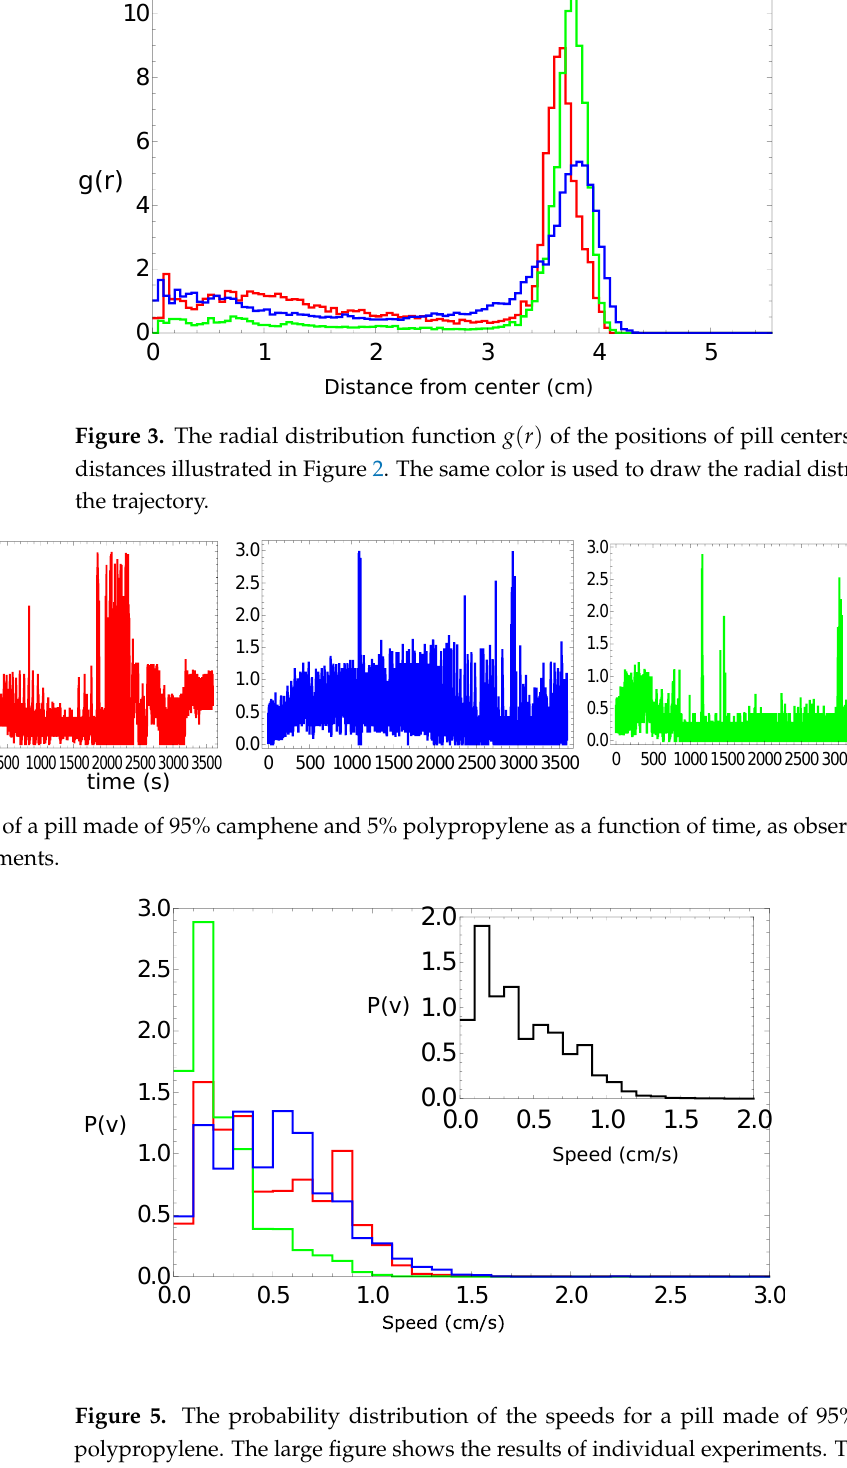
Figure 5. The probability distribution of the speeds for a pill made of 95% camphene and 5% polypropylene. The large figure shows the results of individual experiments. The distribution of the speed values observed in all experiments is shown in the